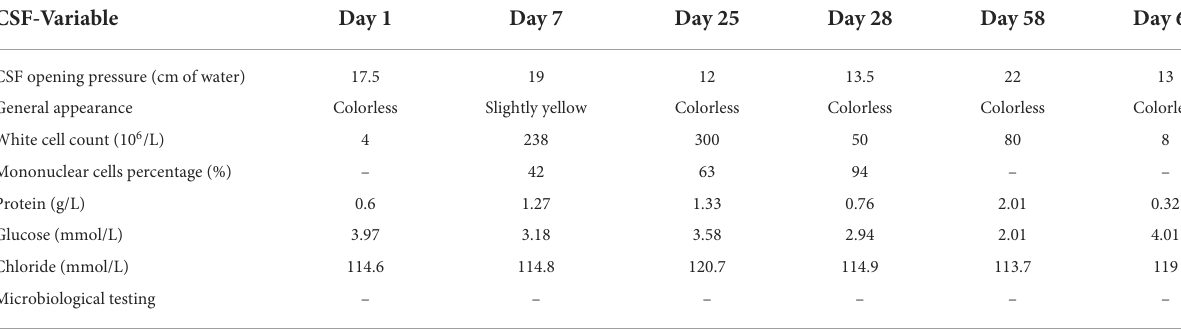
TABLE 1 Dynamic cerebrovascular fluid (CSF) analysis throughout hospitalization.